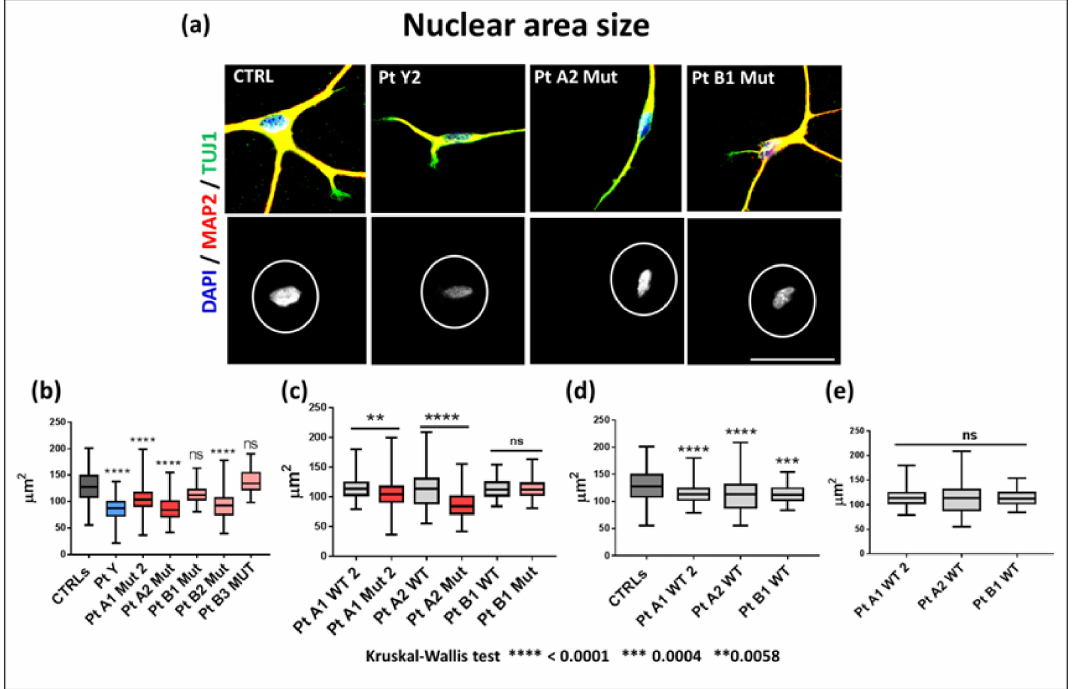
Figure 4. Nuclear area size of young RTT neurons. ( a ) IF staining with pan-neuronal markers MAP2 (red) and TUJ1 (green), counterstaining with DAPI and analysis with Image J software of single young neurons (top panels) and scanned nuclear area size (bottom panels) of a control, PtY2 (p.Gly252Argfs*7), PtA2 Mut and PtB1 Mut i-Neurons. Scale bar: 50 µ m. ( b ) Box-plots representative of the comparison for nuclear area of each mutant clone and a pool of eight healthy controls, four males and four females (CTRLs), ( c ) each isogenic WT clone vs. the correspondent mutant carry- ing the p.Arg255* and p.Arg133Cys, ( d ) between each isogenic WT clone and a pool of controls, ( e ) across WT isogenic clones. Data were compared using Kruskal-Wallis test. **** p -value < 0.0001, *** p -value = 0.0004, ** p -value = 0.0058. ns: not